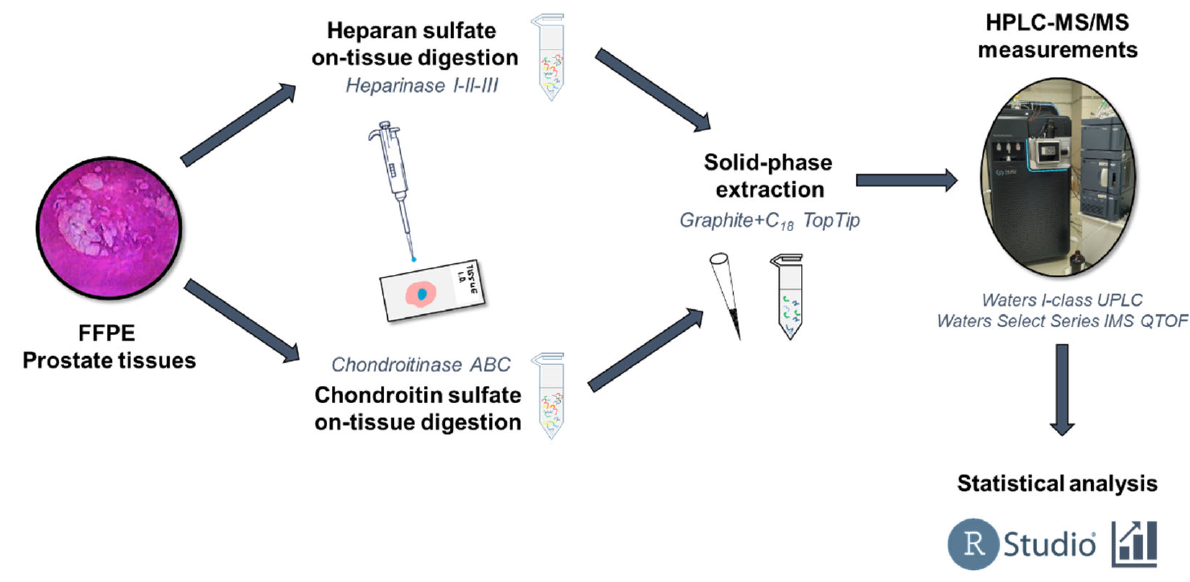
Figure 2. The workflow used in the study.